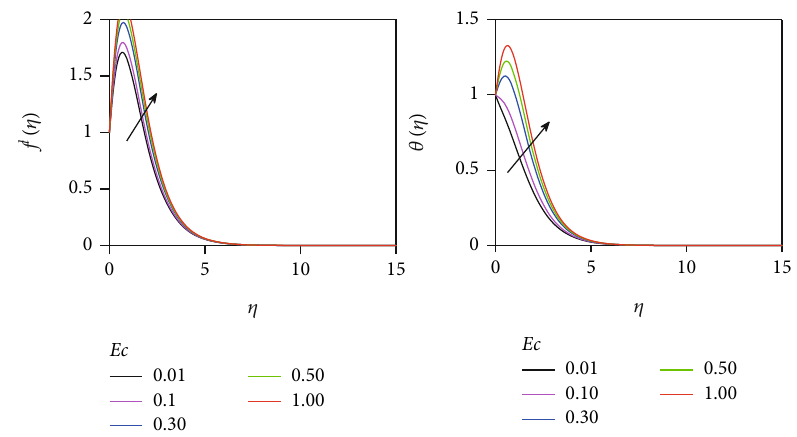
Figure 3: Signi fi cance of the viscous dissipation on velocity and temperature plots.